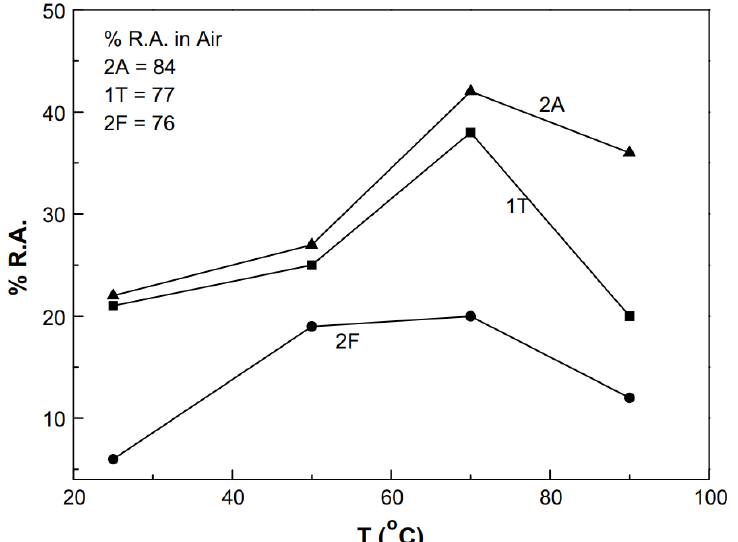
Figure 8. Effect of increasing temperature on percentage reduction in the area for the different microstructures: 2F (martensitic microstructure); 1T (ferritic/bainitic microstructure); 2A (ferritic microstructure) [61]. Reprinted with permission from [61], 2008, Elsevier.